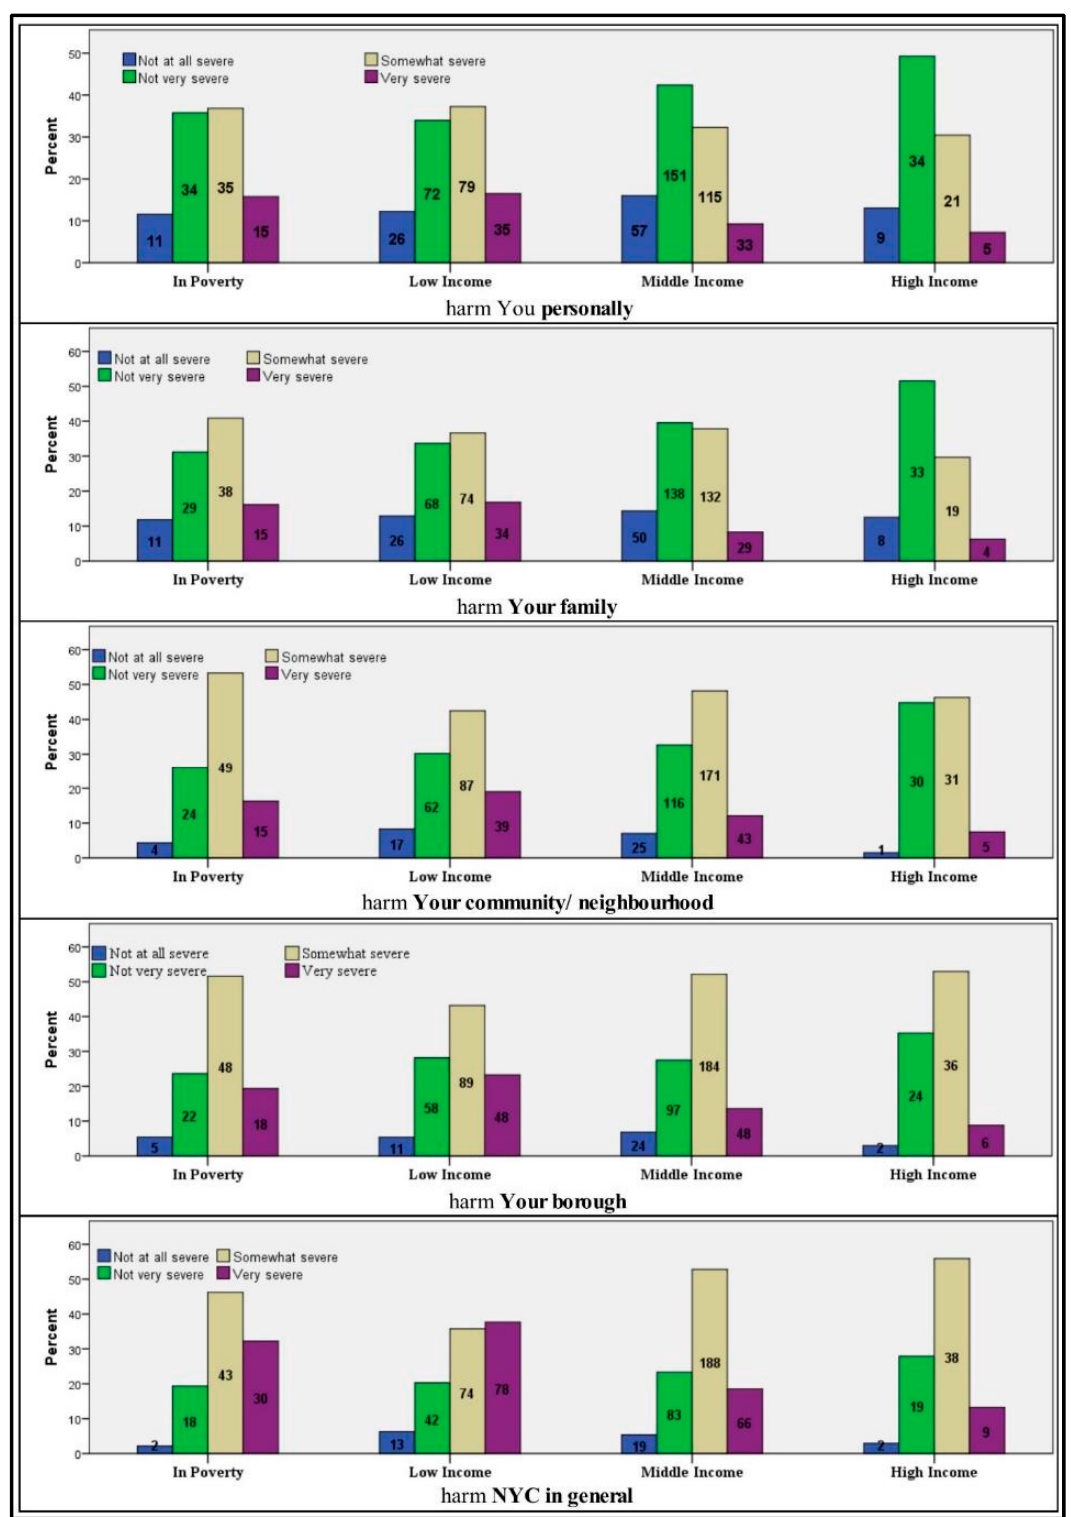
Figure A2. Different income groups concerns about future impacts of heat waves based on different subjects. (the numbers inside the bars represent the number of responses in the data base).